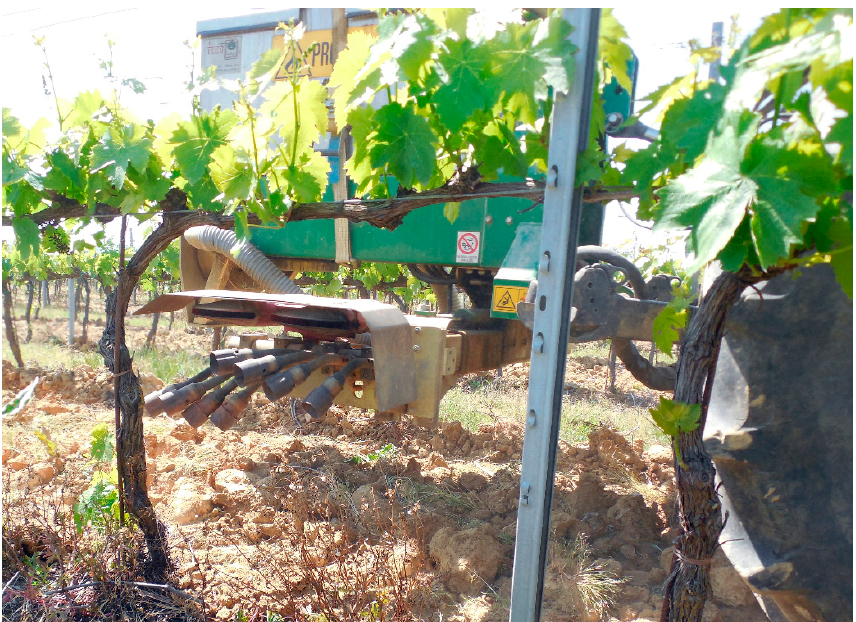
Figure 3. Flame suckering applied on 21 April 2017 at the 13 BBCH sucker growth stage.